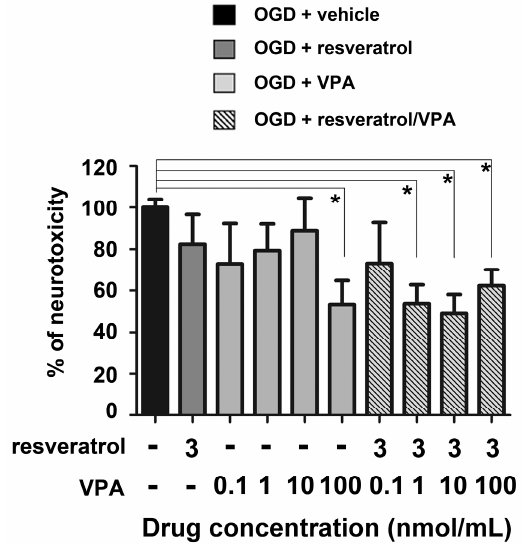
Figure 1. Valproate (VPA) and resveratrol elicited neuroprotective effects in primary cortical